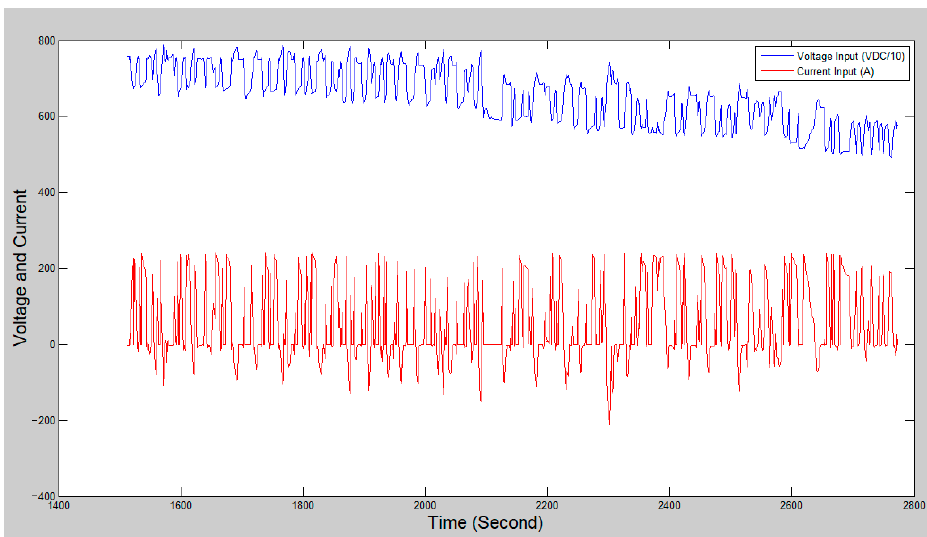
Figure 11. Discharge of batteries.